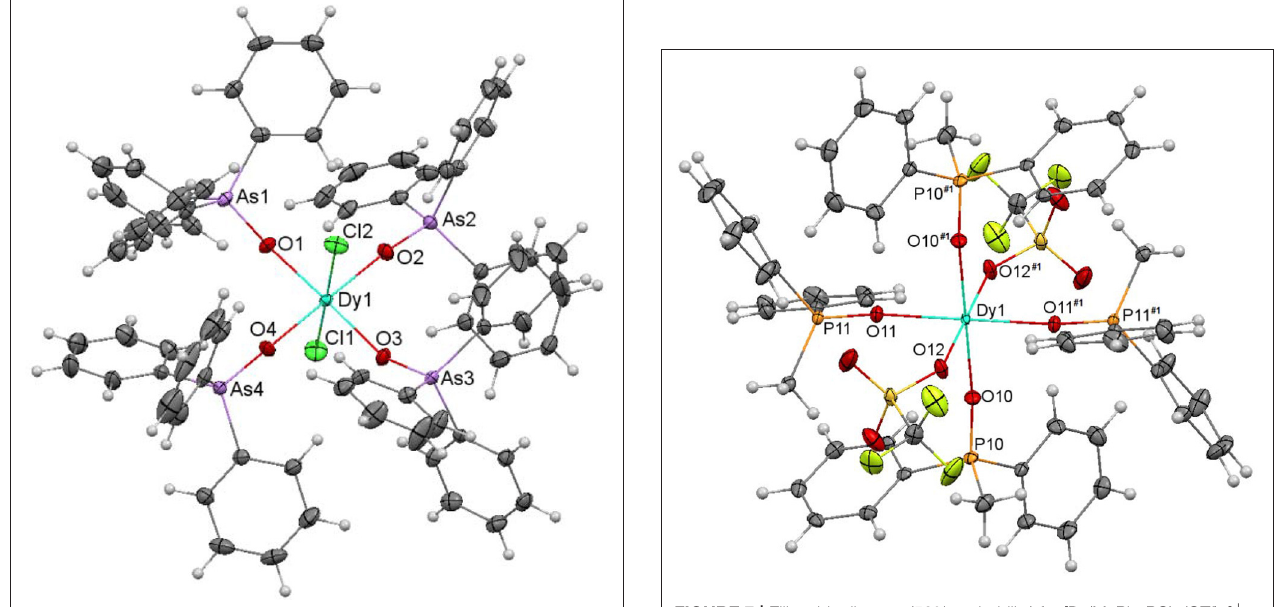
FIGURE 6 | Ellipsoids diagram (50% probability) for [DyCl 2 (Ph 3 AsO) 4 ] + in 5. Only the Dy, As, Cl and donor O-atoms have been labeled, for clarity. Color code: Dy, light blue; As, violet; C, gray; Cl, green; H, light gray; O, red.